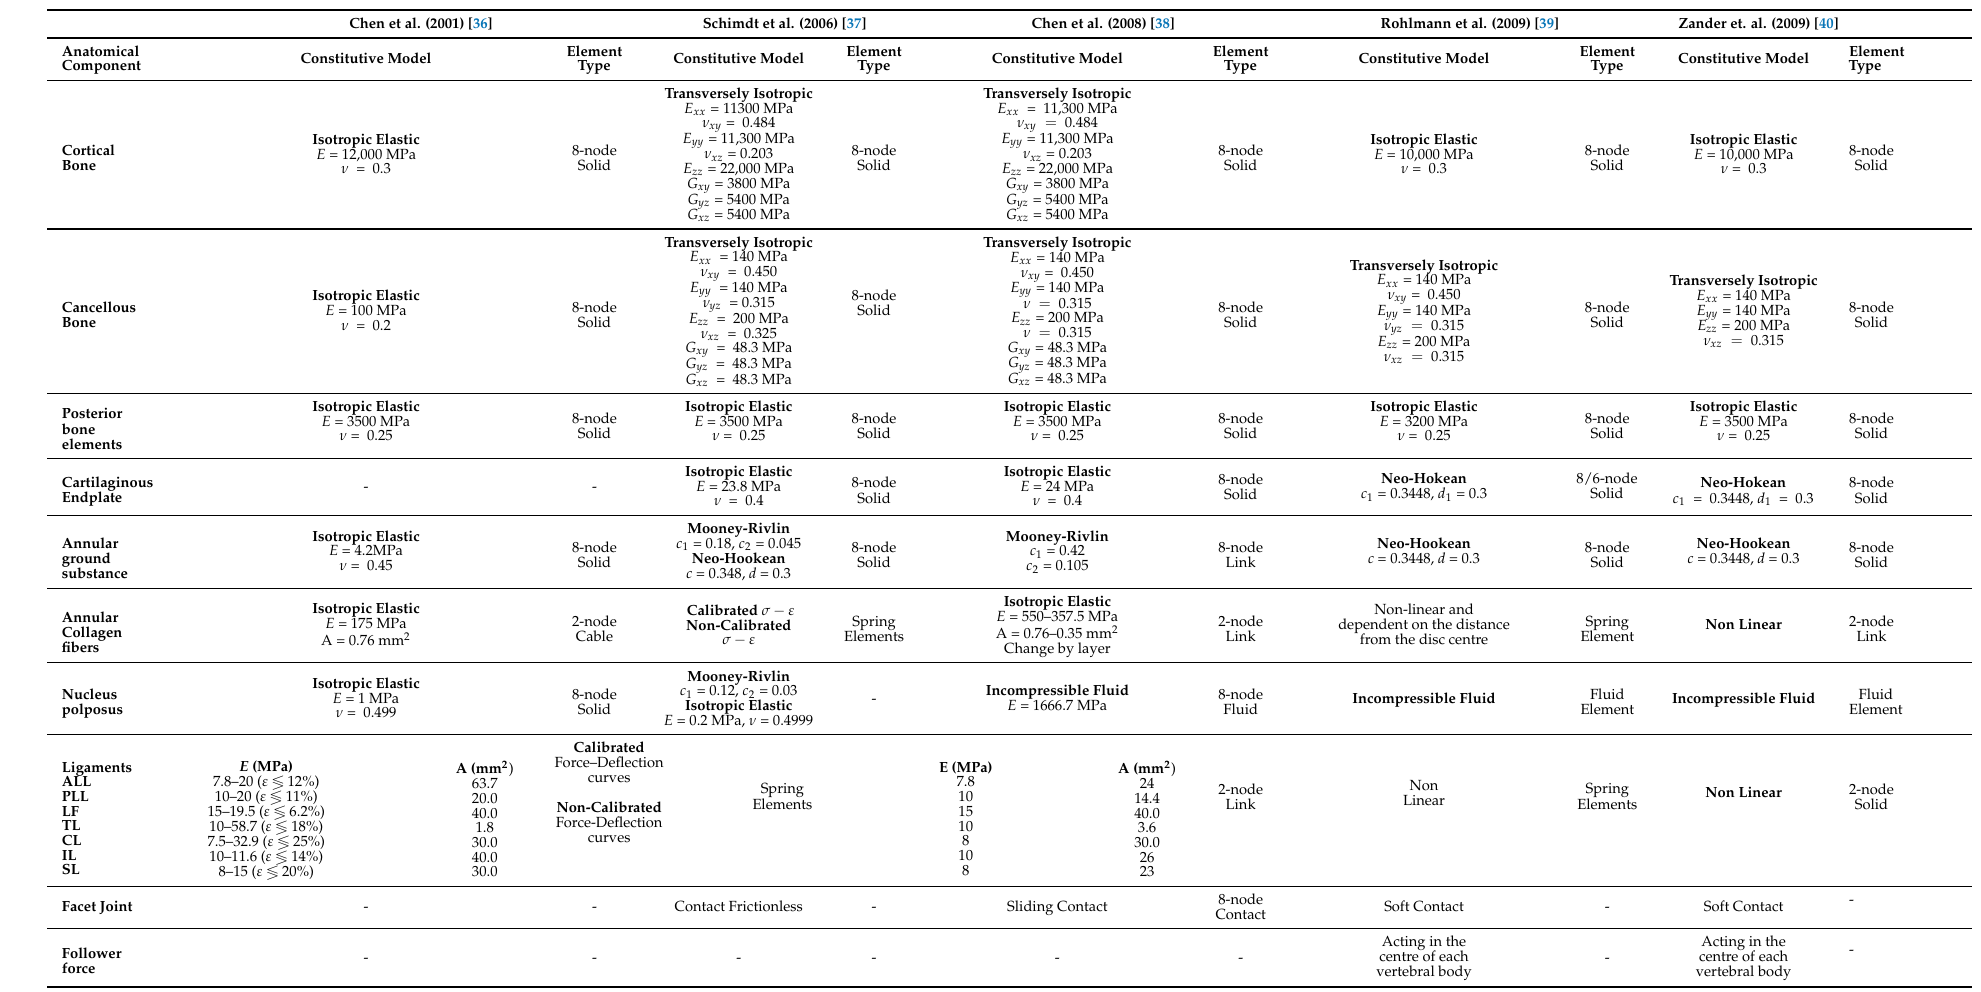
Table A1. The main information extracted from